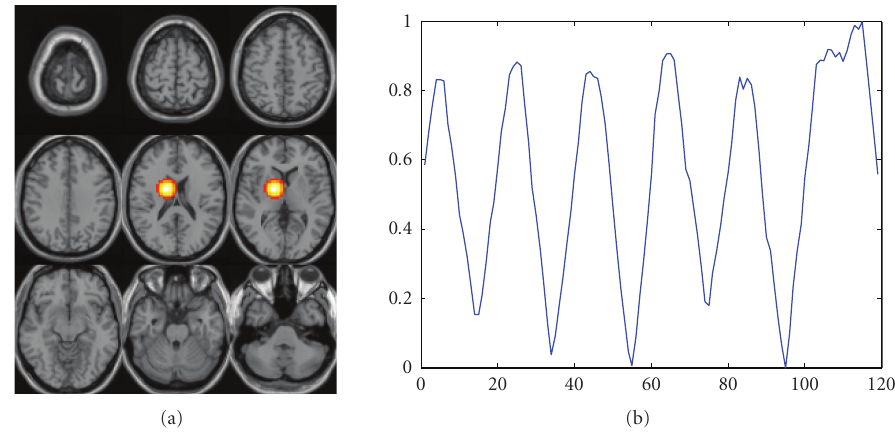
Figure 1: Simulated source superimposed on a resting state fMRI dataset: (a) activation region, (b) time course.